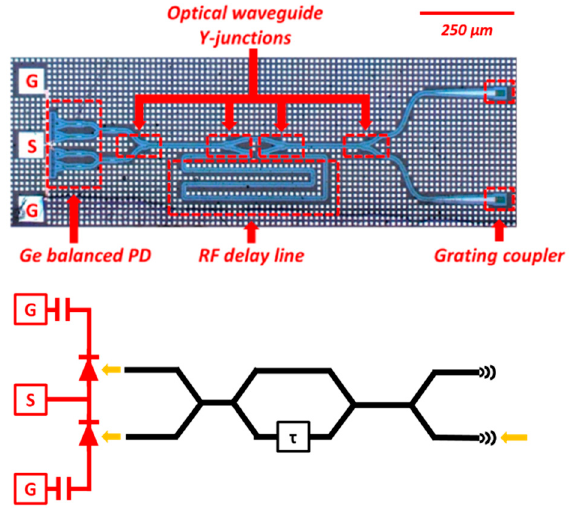
Figure 15. Optical image and schematic of the interferometric demodulator.